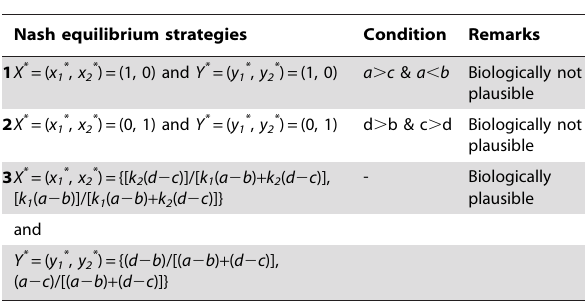
Table 1. Possible Nash equilibria of Host-Pathogen